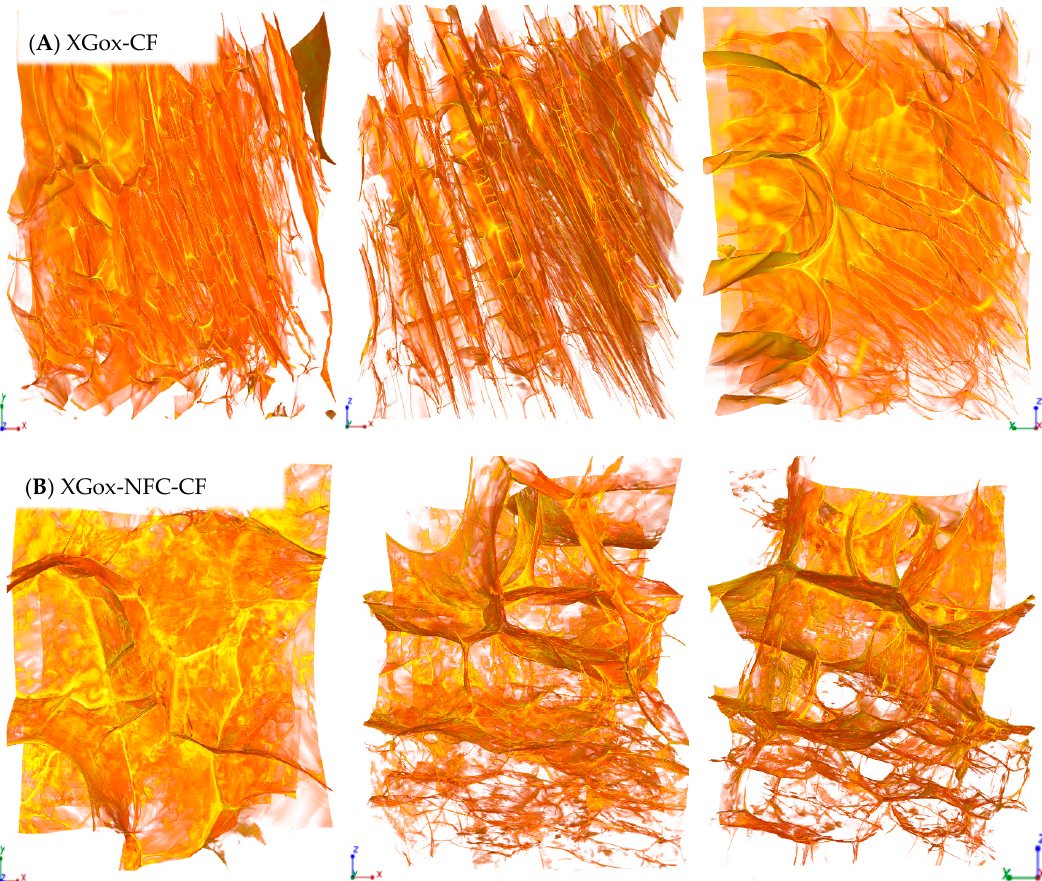
Figure 4. Three-dimensional reconstructed images from synchrotron phase contrast microtomography of ( A ) oxidized XG (XGox) aerogel and ( B ) aerogel reinforced with 25%NFC (XGox-NFC), prepared by conventional freezing (CF). The size is 495.33 × 495.33 × 660.33 μ m 3 in XYZ-axis.